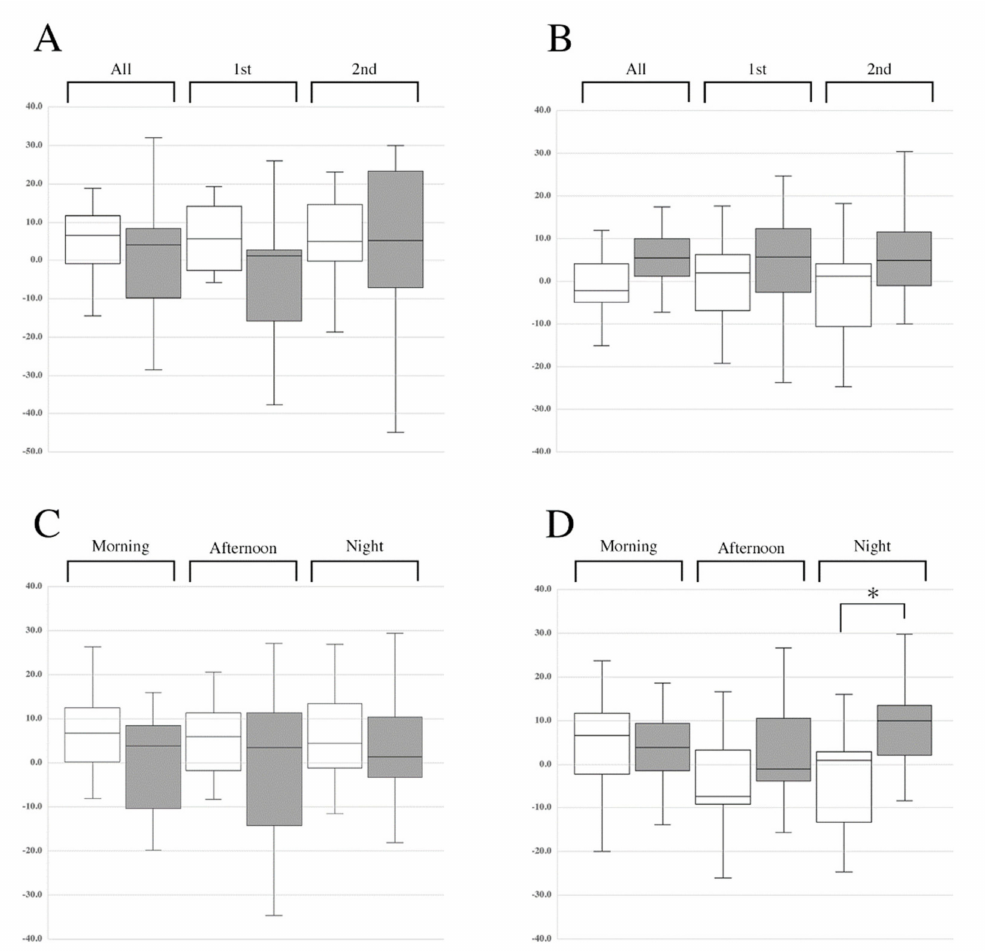
Figure 3. Alteration of subjective feelings in healthy volunteers before and after taking α GPC. Box and whisker plots for changes in anxiety–relief ( A , C ) and lethargy–motivation ( B , D ) in placebo (white bars) and α GPC (colored bars) groups. ( A , B ) Dosing period, All: entire period (1st and 2nd week), 1st: first week, 2nd: second week. ( C , D ) Time blocks (morning, afternoon, and night). Boxes represent the first and third quartiles. Whiskers represent the range from minimum to maximum of observed data. * p <